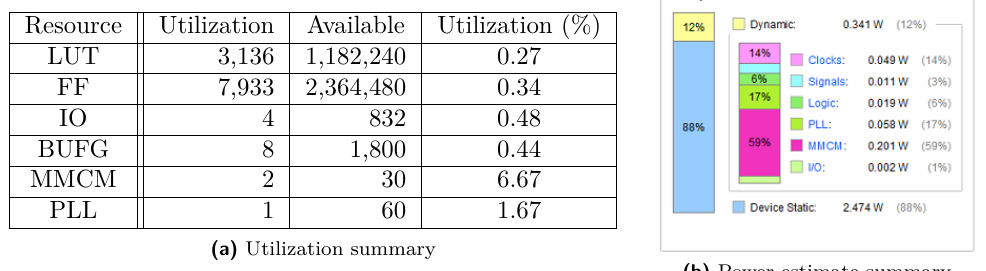
Figure 15: Resource utilization and power estimate summaries